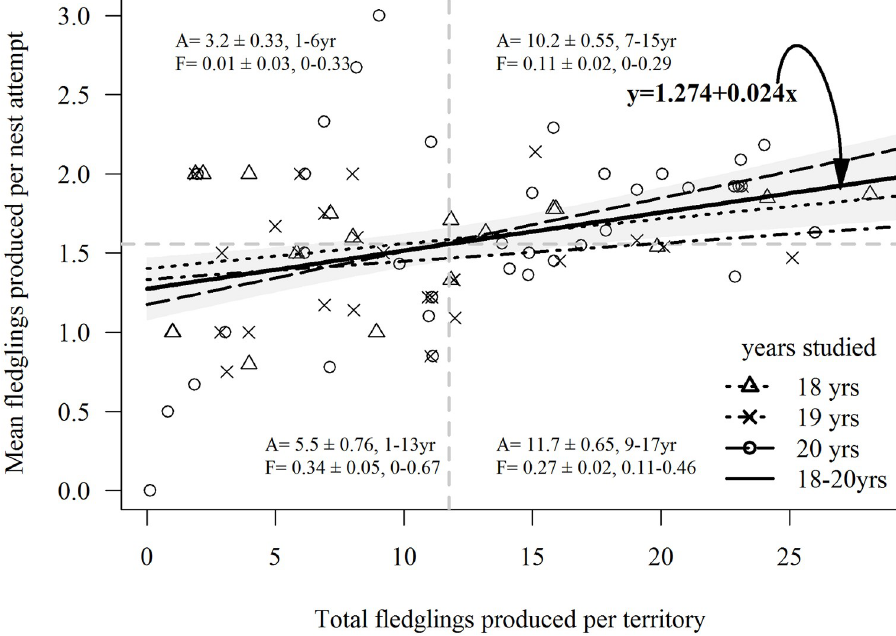
Fig 17. Are fewer fledglings per breeding attempt produced on less productive (low quality?) territories than on more productive (high quality?) territories? Linear regressions of mean numbers of fledglings produced per breeding attempt on low productivity vs. high productivity territories and the sum total fledglings produced by 3 different cohorts of territories (36 territories monitored 20 years [1991–2010]; 25 territories monitored 19 years [1992–2010]; and 18 territories monitored 18 years [1993–2010]) by northern goshawks in Arizona, USA. Territories in each cohort are divided into 4 quadrants based on their mean total fledglings produced per study period (vertical line) and means of numbers of fledglings produced per breeding attempt (horizontal line). Means ( ± SE) and ranges of numbers of years that territories were active (A; eggs laid), and means ( ± SE) and ranges of nest failures (F) are provided for each